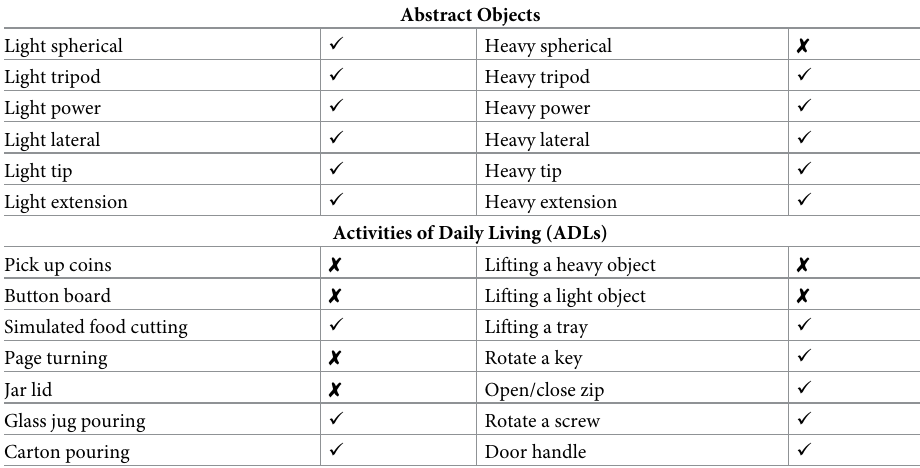
Table 1. Tasks involved in the SHAP